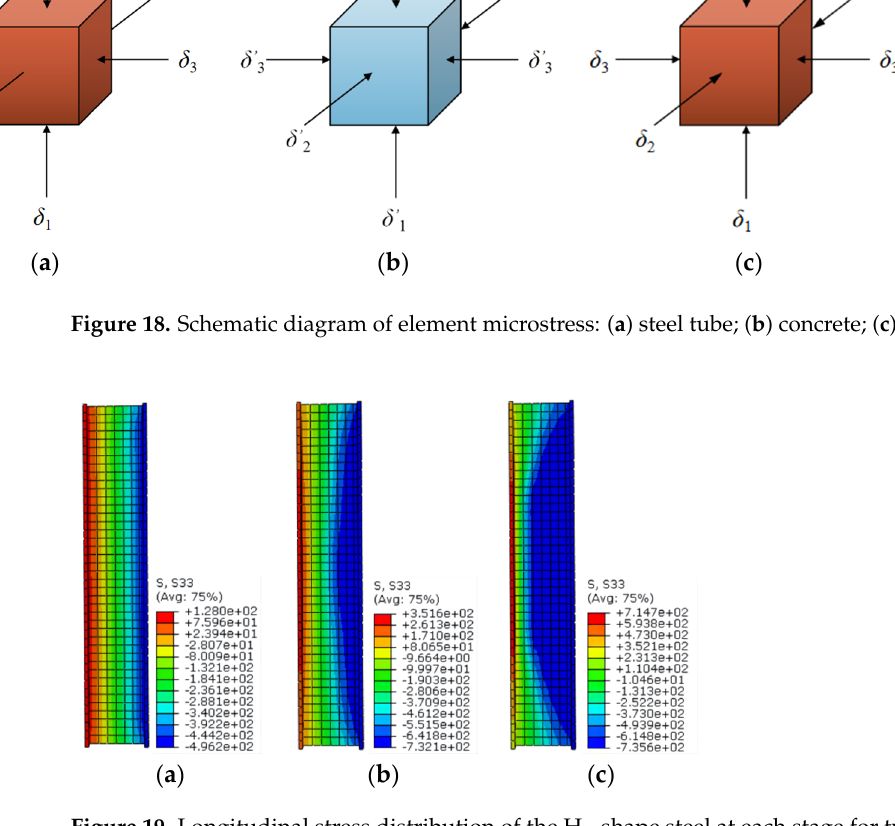
Figure 18. Schematic diagram of element microstress: ( a ) steel tube; ( b ) concrete; ( c ) H-shape steel.